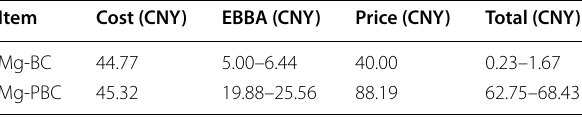
Table 4 Costs and benefits of per kg of Mg-BC and Mg-PBC in engineering